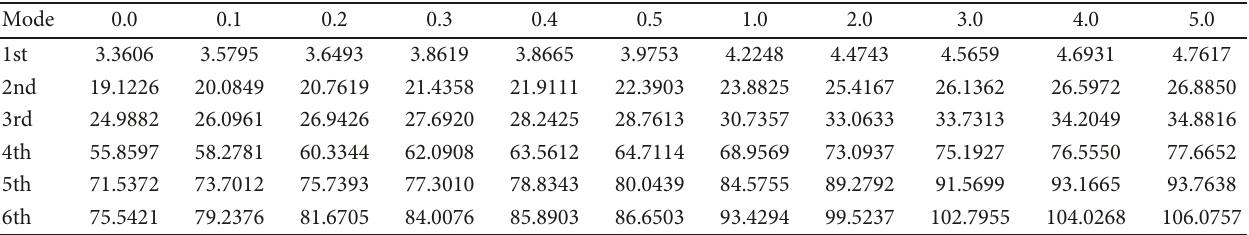
Table 10: Nondimensional frequency parameters for the fi rst six modes of the FG sandwich blade with varying scalar parameters of volume fraction ( l = 3 , h = 20 , h = 1/2 , and θ = 30 ° ). l